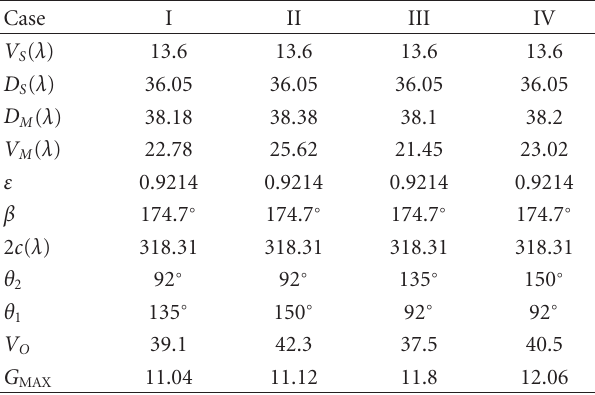
Table 1: Design parameters of Cases